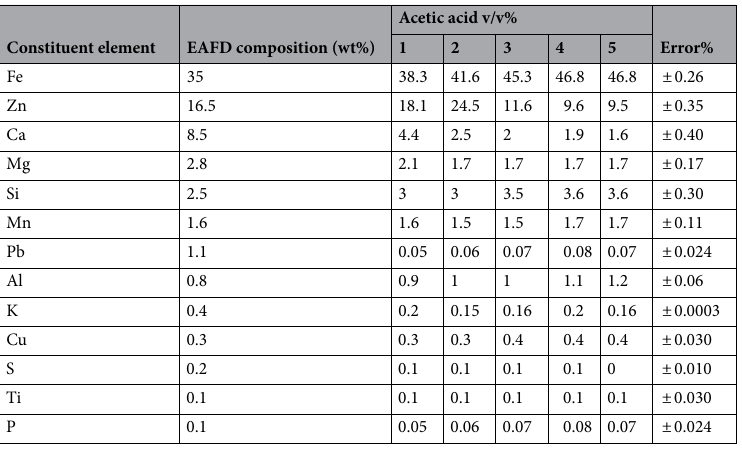
Table 2. Chemical composition of the